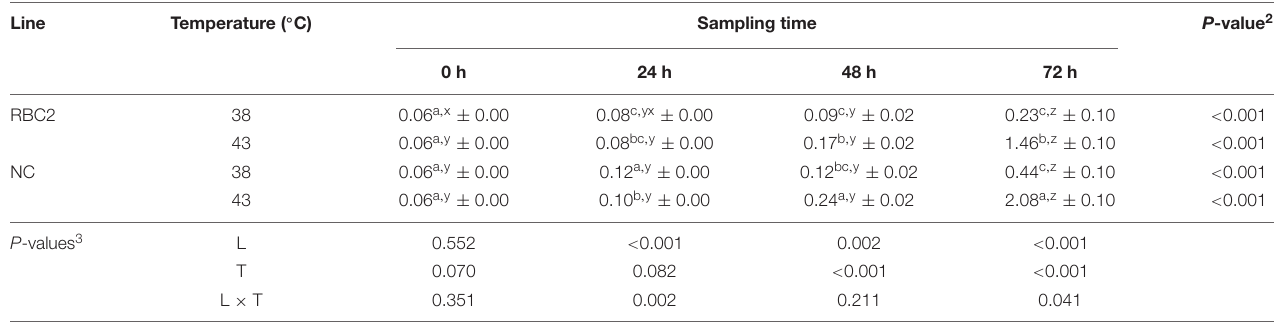
TABLE 3 | Effect of heat stress (43 ◦ C) on lipid accumulation during proliferation of satellite cells isolated from the pectoralis major muscle of Randombred Control Line 2 (RBC2) and Nicholas Commercial (NC) turkeys 1 . Line Temperature ( ◦ C) Sampling time